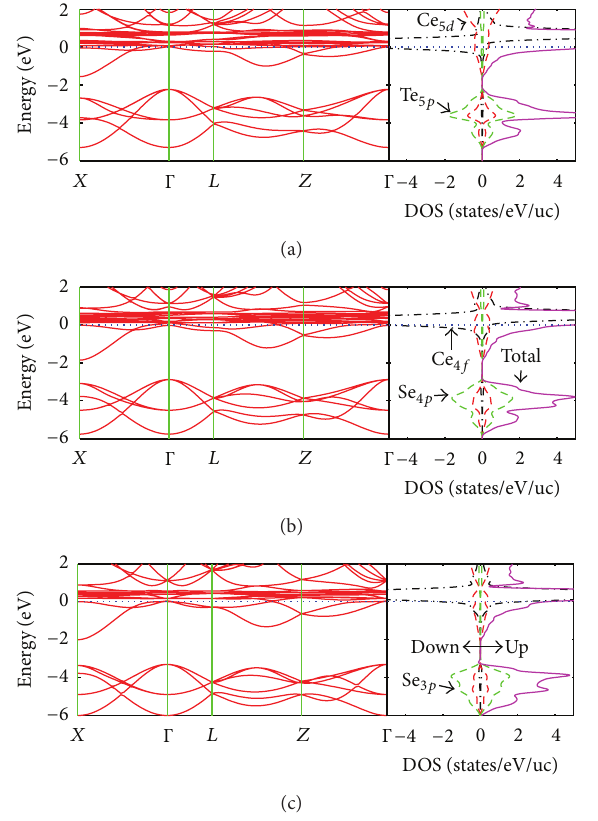
Figure 5: Electronic band structure along high symmetry lines of the first Brillouine zone and total and the partial densities of electronic states for (a) CeS, (b) CeSe, and (c) CeTe.